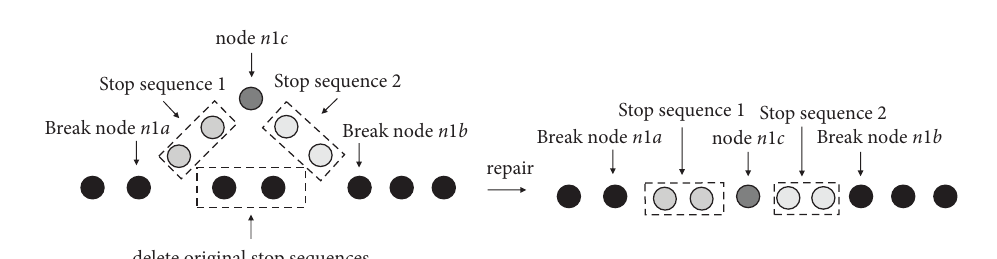
Figure 2: Situation 1 in the length repair operator.